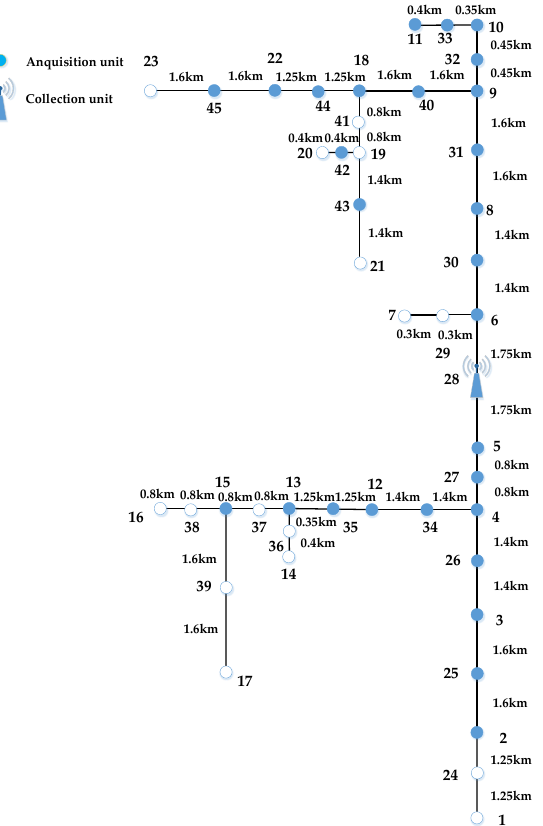
Figure 11. The installation position of IoT-based fault indicator when the junction nodes of the power line change. Table 5. Optimal placement of fault indicators under different junction nodes of the power line.